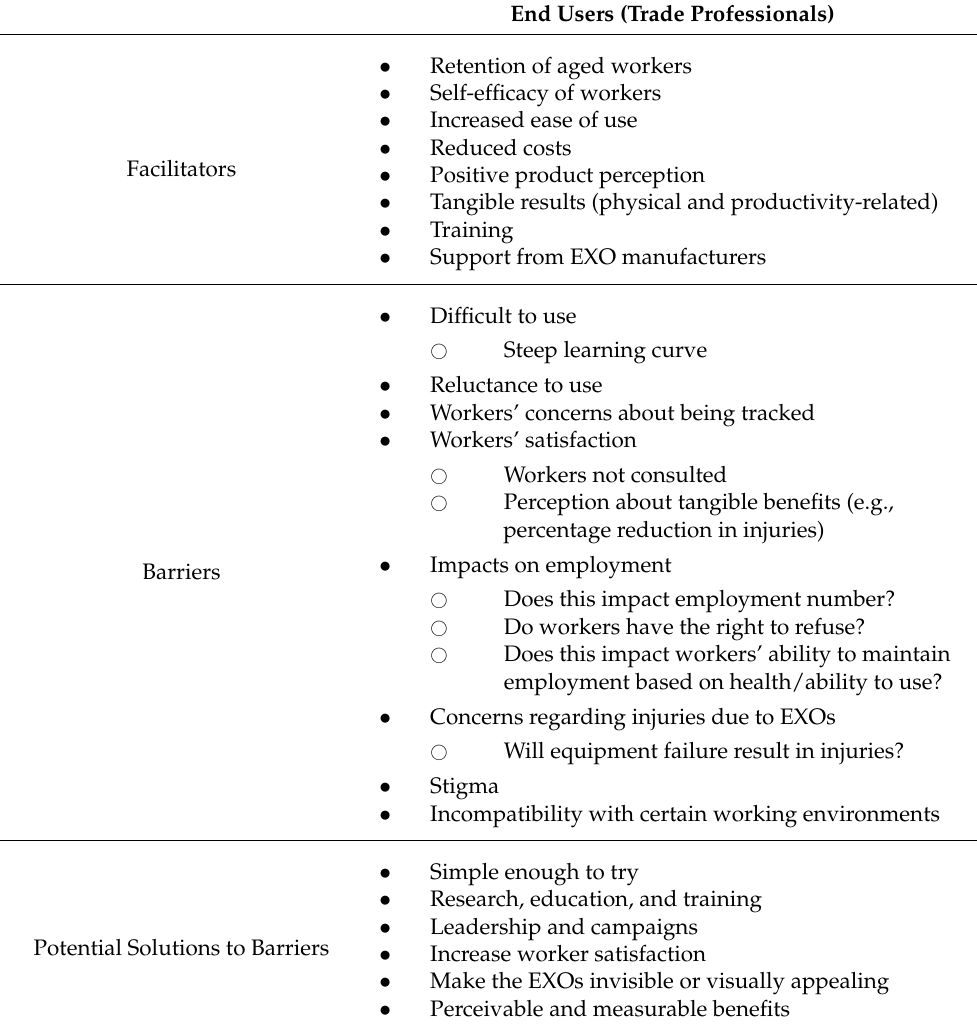
Table 8. Summary of end users (trade professionals) category